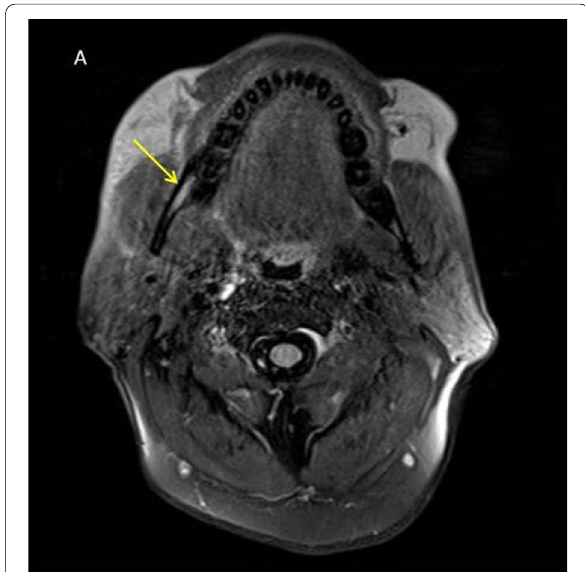
Fig. 7 T1 post-contrast axial sequence showing thickened enhancing right inferior alveolar nerve (arrow)